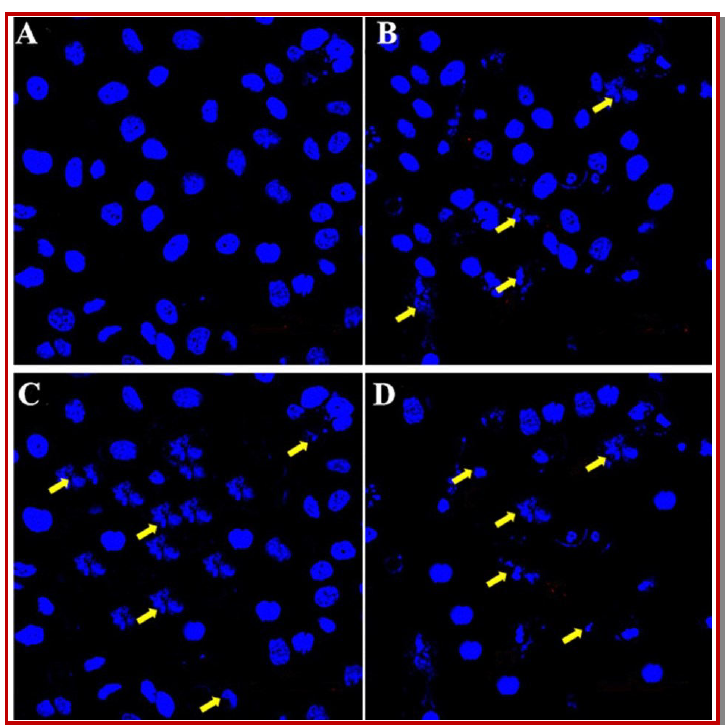
Figure 3: Effect of caryophyllene oxide on the apoptosis induction in MG-63 human osteosarcoma cells. The cells were treated with 0 (A), 20 (B), 80 (C) and 120 (D) μ M dose of caryophyllene oxide, stained with Hoechst 33342 and then observed under fluores- cence microscope at 400x